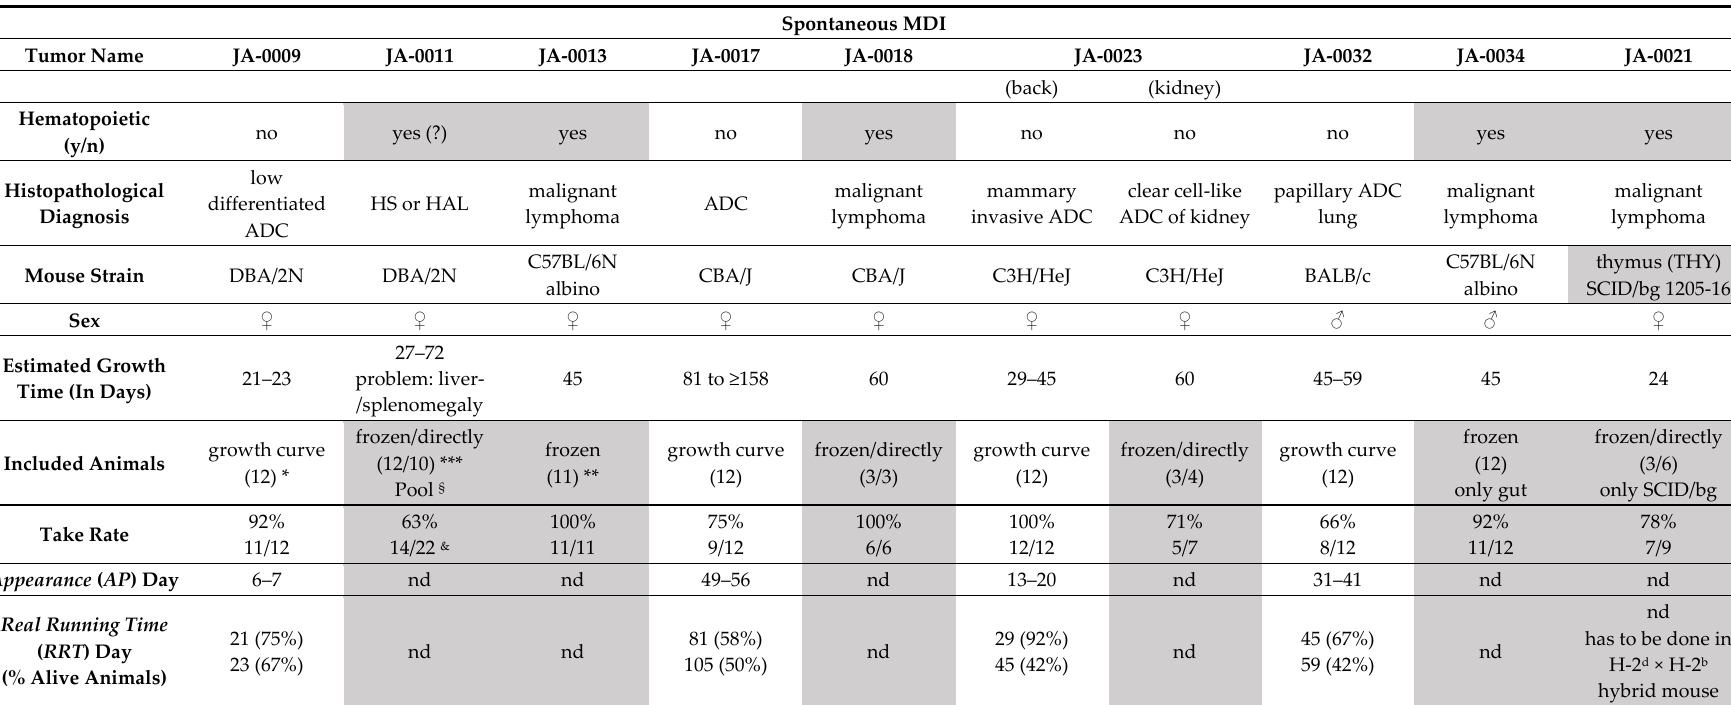
Cancers 2019 , 11 , x Table 1. Established spontaneous mouse-derived isograft (sMDI) models, summarizing the characteristics of established sMDIs.